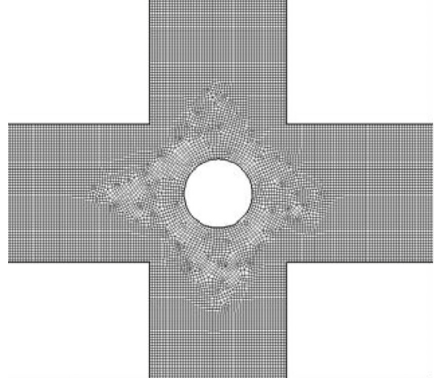
Figure 3: Mesh division of cross micropump.